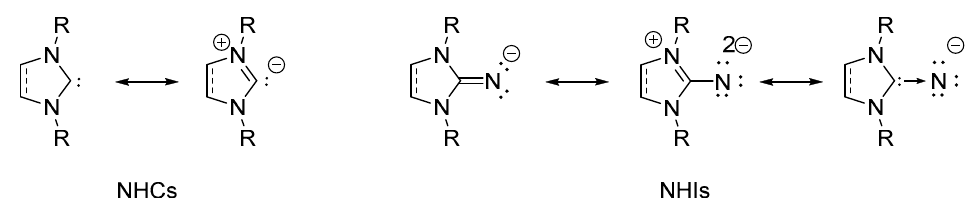
Figure 1. Archetypal ligand systems comprising the five-membered N-heterocycle structural motif and resonance forms. NHC: N-heterocyclic carbene; NHI: N-heterocyclic imine.